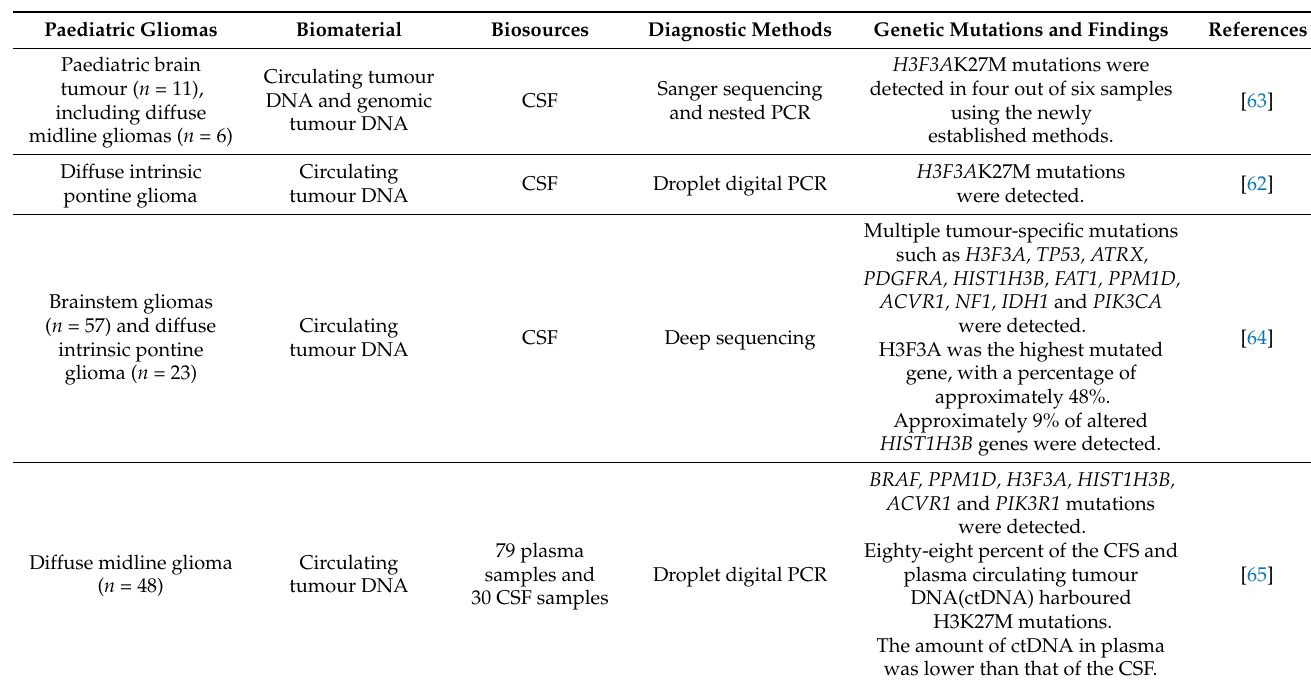
Table 1. A summary of the liquid biopsies used for detecting H3 mutations in paediatric high-grade gliomas (pHGGs). CSF: cerebrospinal